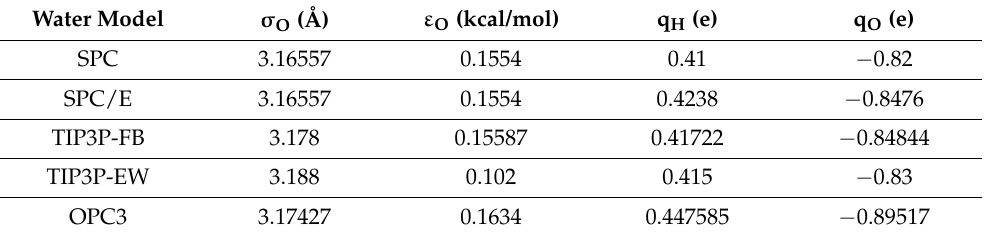
Table 1. LJ parameters and atomic charges employed for water molecules in this